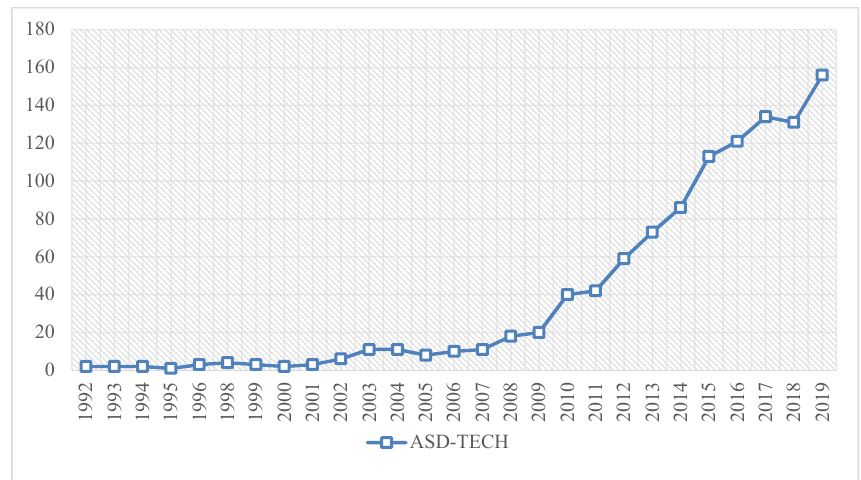
Figure 2. Evolution of research volume.